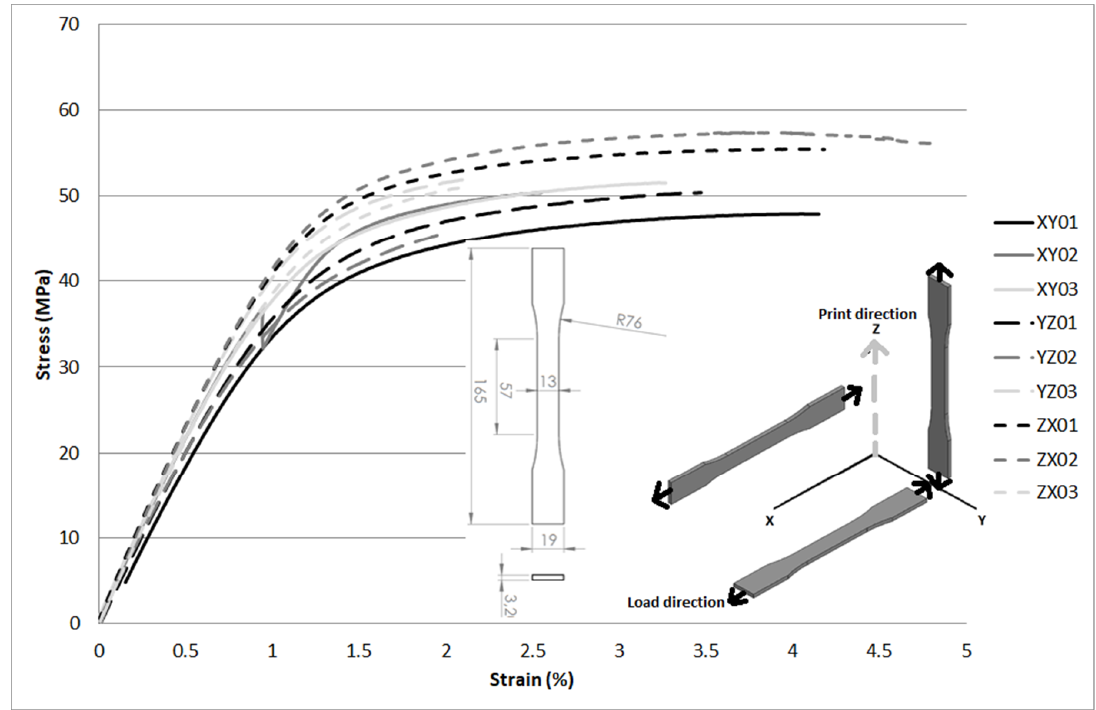
Figure 2. Tensile tests for several fabrication directions using D638 Type I specimens.